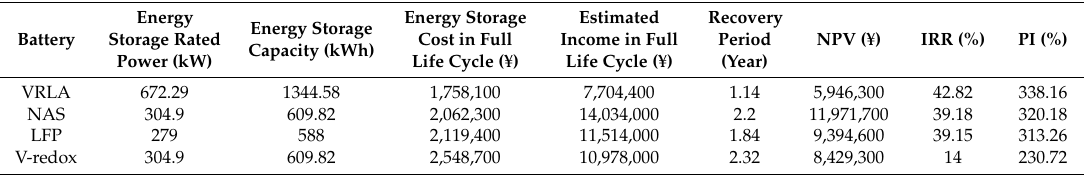
Table 4. Energy storage configuration and economic evaluation results of demand management.